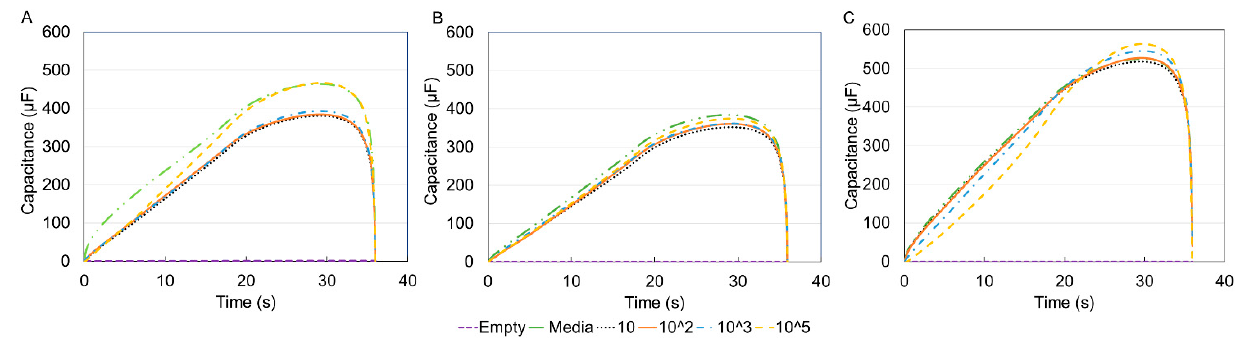
Figure 8. Capacitance–time curve for the three types of cells before media de-embedding (removing the value of media from the rest of the samples) ( A ) THP-1, ( B ) DCs, ( C ) MACs. Capacitance values were extracted using MATLAB, based on the fact that the capacitive current measured is proportional to the rate of change of the applied potential with the constant of proportionality equal to the capacitance. There is no consistent trend between the concentration and capaci- tance.